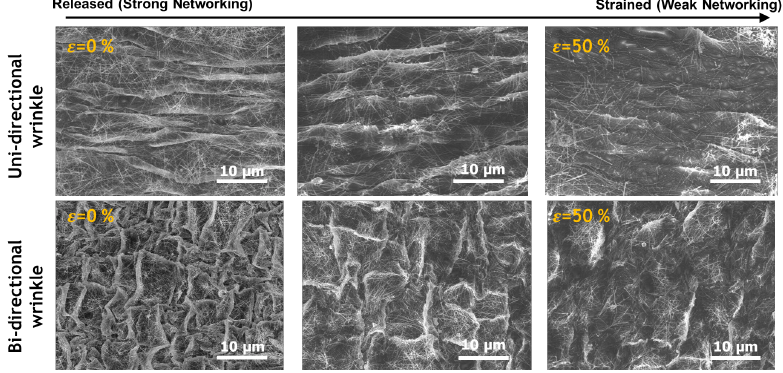
Figure 3. Morphology changes in the electrode surfaces with mechanical tensile strains.